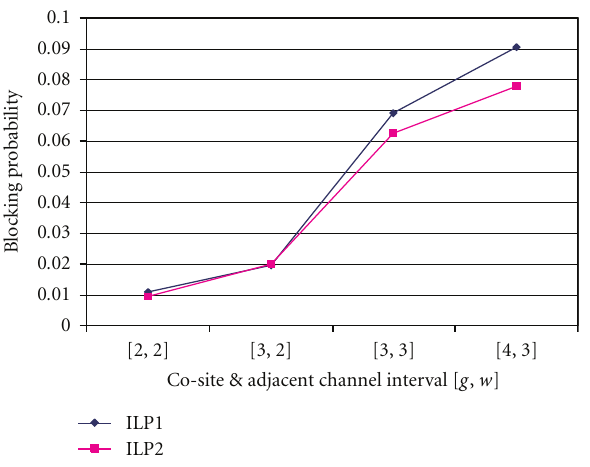
Figure 10: Performances of ILP1 versus ILP2 for ratio 35 :35 with initial tra ffi c load.